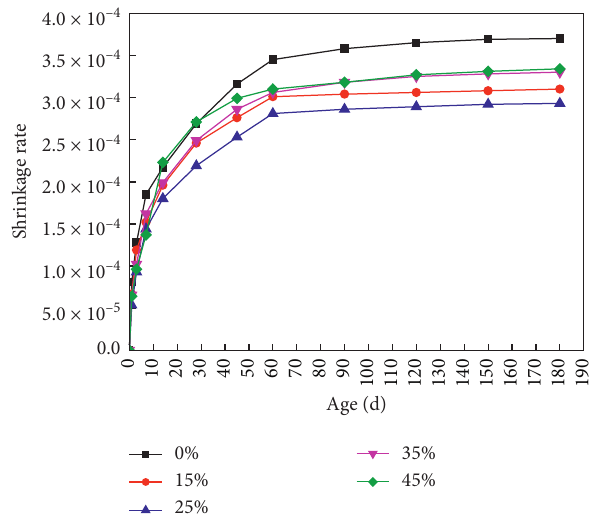
Figure 3: Effects of varying fly ash substitution levels (0, 15, 25, 35, and 45%) on the CFA’s drying shrinkage rate under constant temperature (20 ± 2 ° C) and relative humidities (60 ± 5%).